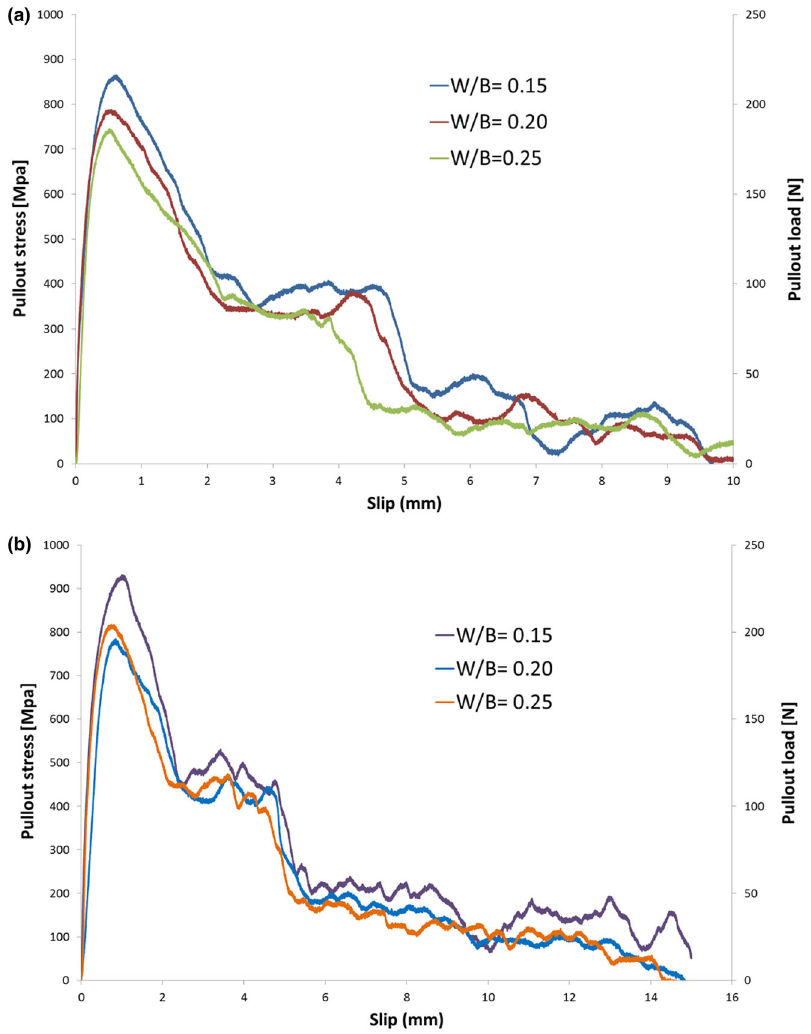
Fig. 6 Average pullout load-slip curves of 3DH1 fibres. a Embedded length (10 mm), b embedded length (16